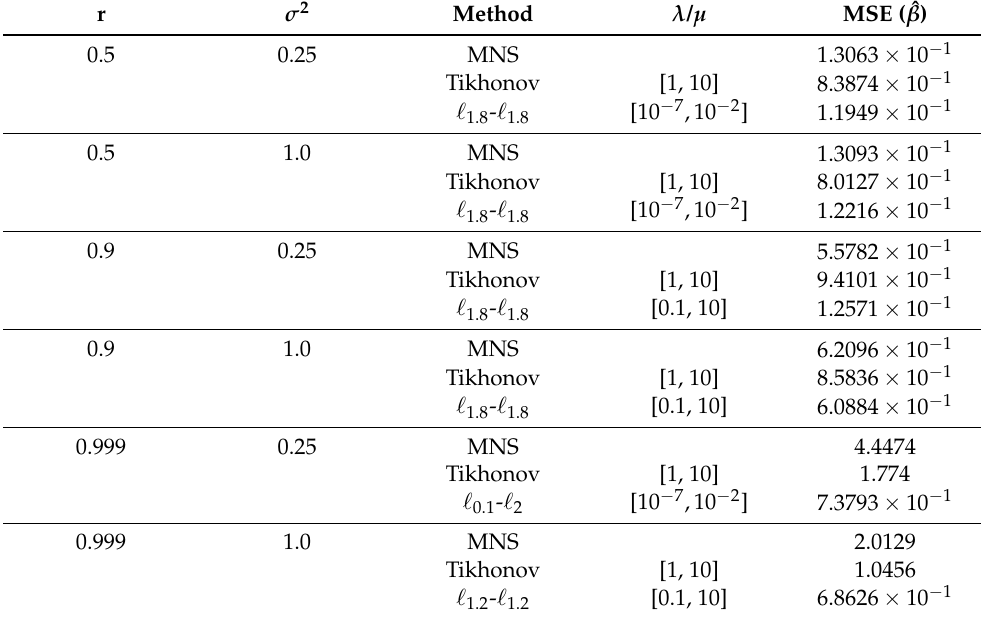
Table 1. Results for X 5 × 21